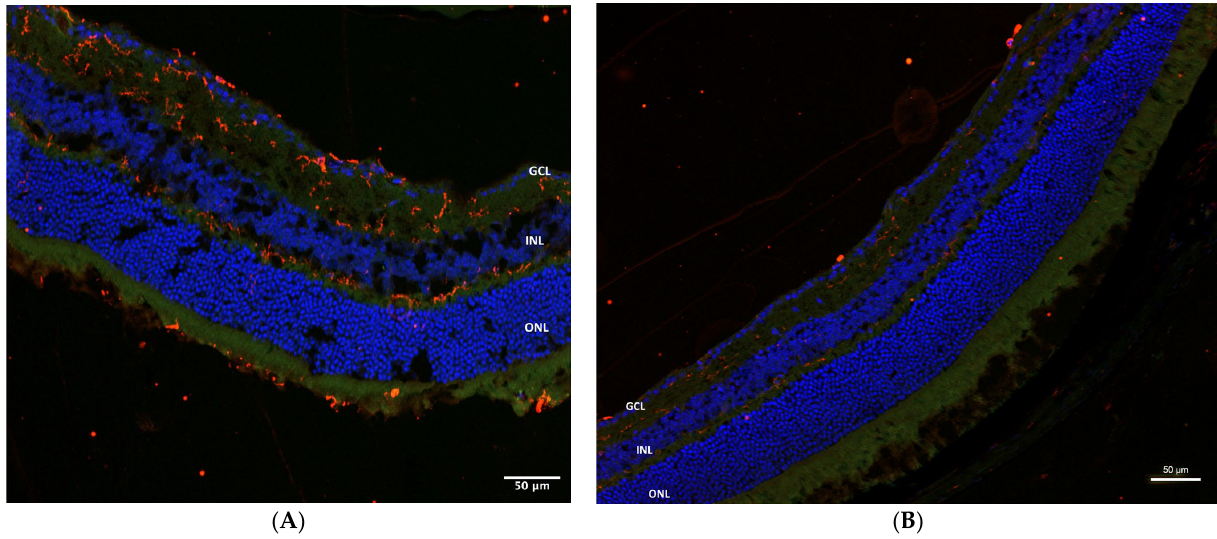
Figure 6. CD45 immunohistochemical staining in AZ-treated eyes: TLR4KO mice . ( A ) Inflammatory reaction is apparent in the retinal layers of the microbead-injected right eyes. ( B ) No staining is seen in the control left eyes. CD45, red; DAPI, blue. AZ, azithromycin; TLR4KO, toll-like receptor 4 knockout.